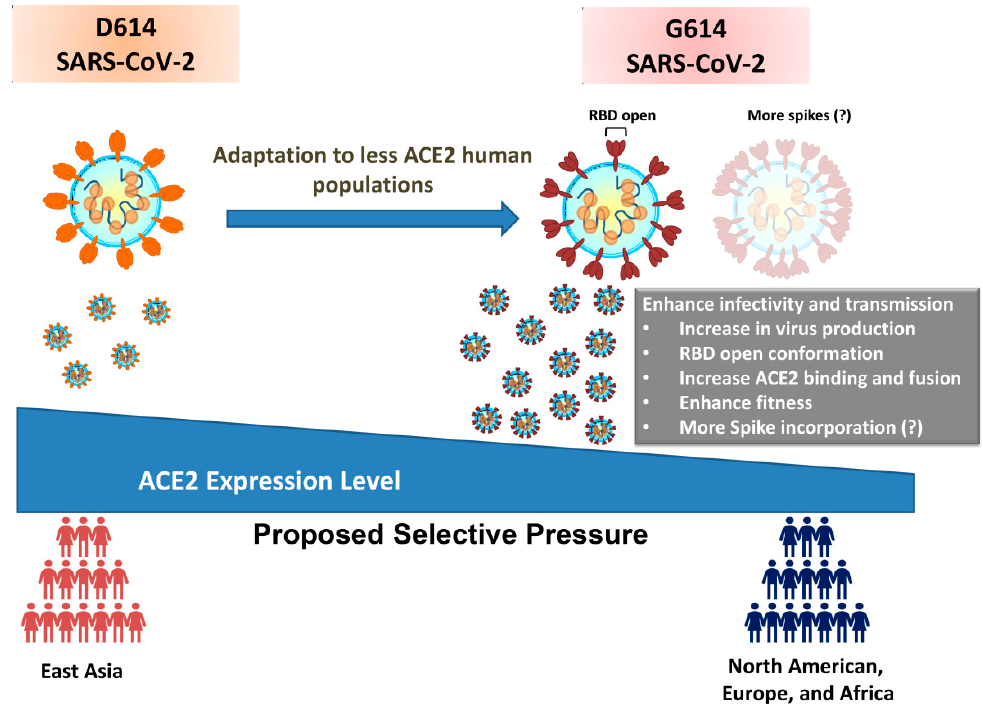
Figure 2. Genetic variability in ACE2 expression as potential driving force for presence of D614G mutation in SARS-CoV-2 S glycoprotein.